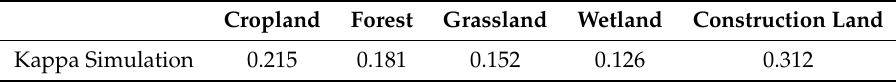
Table 5. Kappa simulation score for the calibration